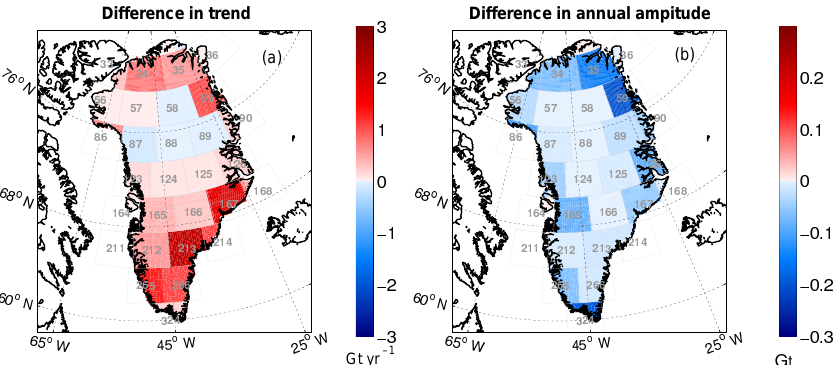
Figure 6. Difference in (a) trend and (b) annual amplitude of (ISSM_GrIS − SMB_GrIS) showing the contribution from SMB-driven dy- namics, as calculated by ISSM, to both the trend and annual amplitude. Here, we define SMB-driven dynamics as the difference between the ISSM-simulated mass balance and the mass balance predicted by SMB anomalies alone. A spatial representation of the difference between ISSM_GrIS and SMB_GrIS ice thickness change over the study period (plotted on the ISSM mesh) is presented in Fig. S9.